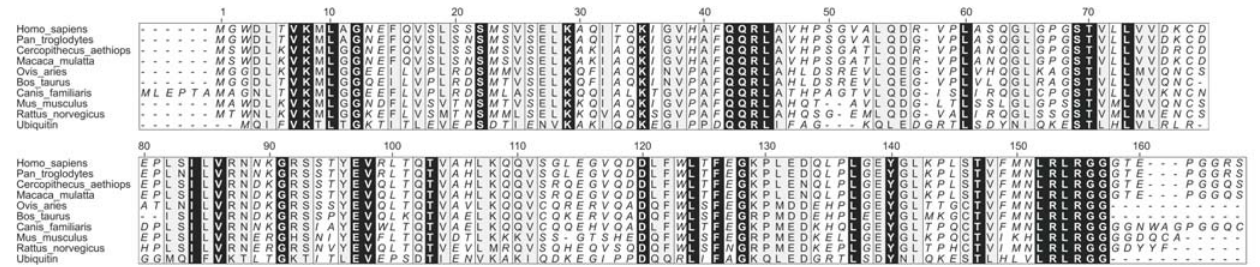
Figure 1. ISG15 orthologues show a low degree of amino acid conservation. ISG15 from different species were aligned with two molecules of Ubiquitin using Clustalx [61]. Sequence conservation is visualized using the AMAS server [62] with a conservation threshold of 7. Residues with a conservation above this threshold are shown on a grey background, residues that are identical in all sequences have a black background.